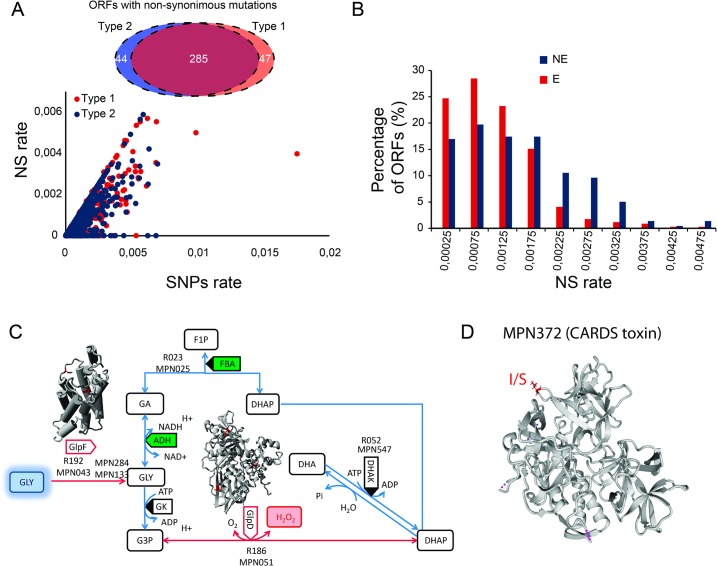
Study of common mutations in type 1 and type 2 strains.A) The Venn diagram indicates the number of genes showing non-synonymous mutation in type 1 strains (red circle) and in type 2 strains (blue circle). The dots in the graph indicate the SNPs versus non-synonymous (NS) rates for all the genes in type 1 (red dots) and type 2 (blue dots). B) The histogram represents the number of genes versus densities of non-synonymous mutations in type 2 strains for essential ORFs (E, red bars) and non-essential ORFs (NE, blue bars). Essentiality categories were described in Lluch-Senar et al [47]. C) Representation of the glycerol pathway in M. pneumoniae metabolism. The protein structures of the orthologous GlpF and GlpD proteins of Escherichia coli [52, 53] are represented in grey and the corresponding mutated residues in M. pneumoniae are represented in red. Red arrows represent the reactions where both proteins are involved. D) Protein structure of M. pneumoniae CARDs toxin [56]. The mutated amino acid is represented in red in the protein structure.